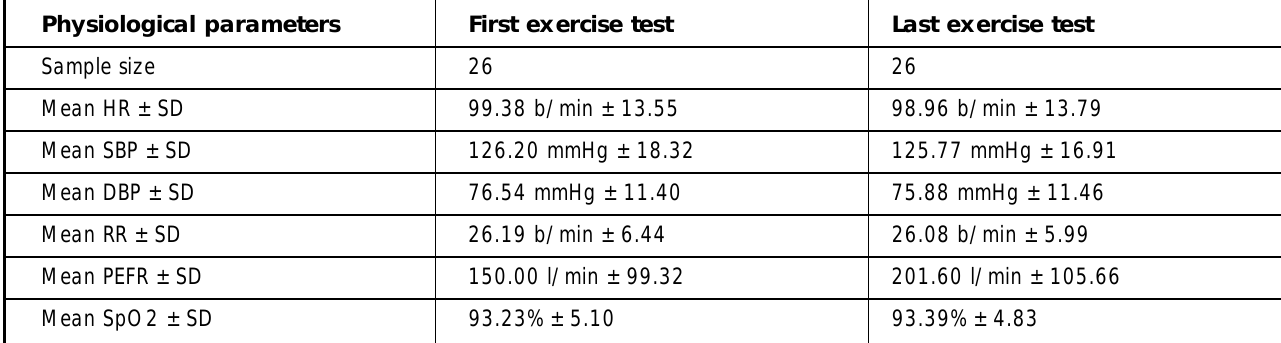
Table 4: Baseline physiological parameters of the first and last exercise